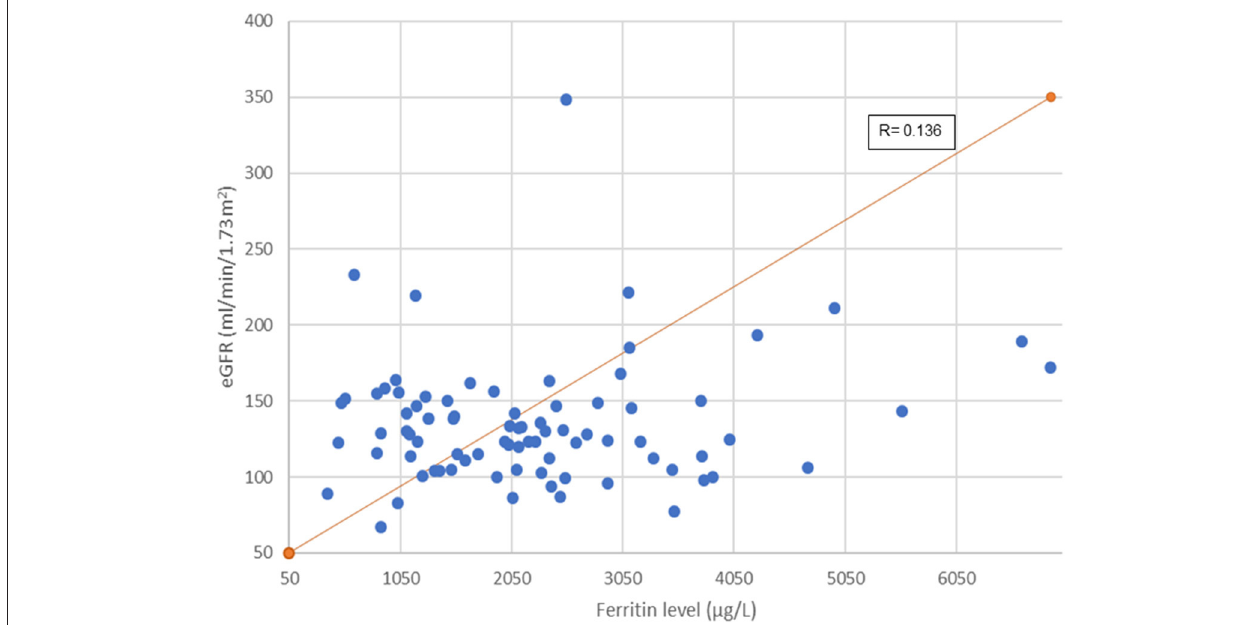
FIGURE 2 | Scatter plot showing correlation of ferritin level and eGFR.